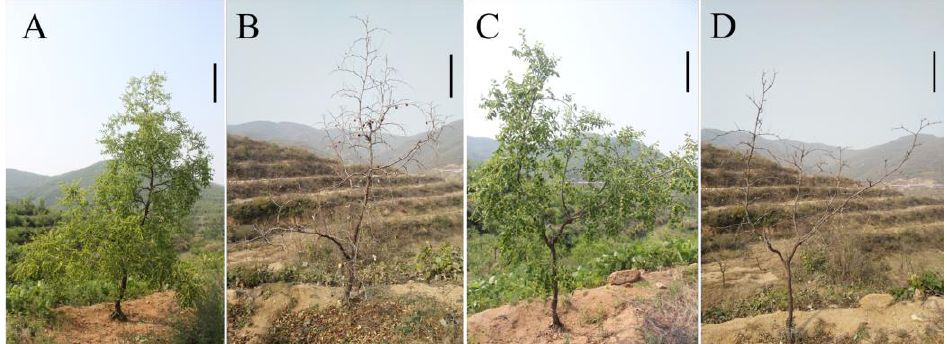
Figure 2. The morphological difference between ‘Xingtai0604′ (diploid) and ‘Zhuguang’ (autotetraploid). ( A ) and ( B ), ‘Xingtai0604′ . ( C ) and ( D ) , ‘Zhuguang’. Bars = 0. 5 m.